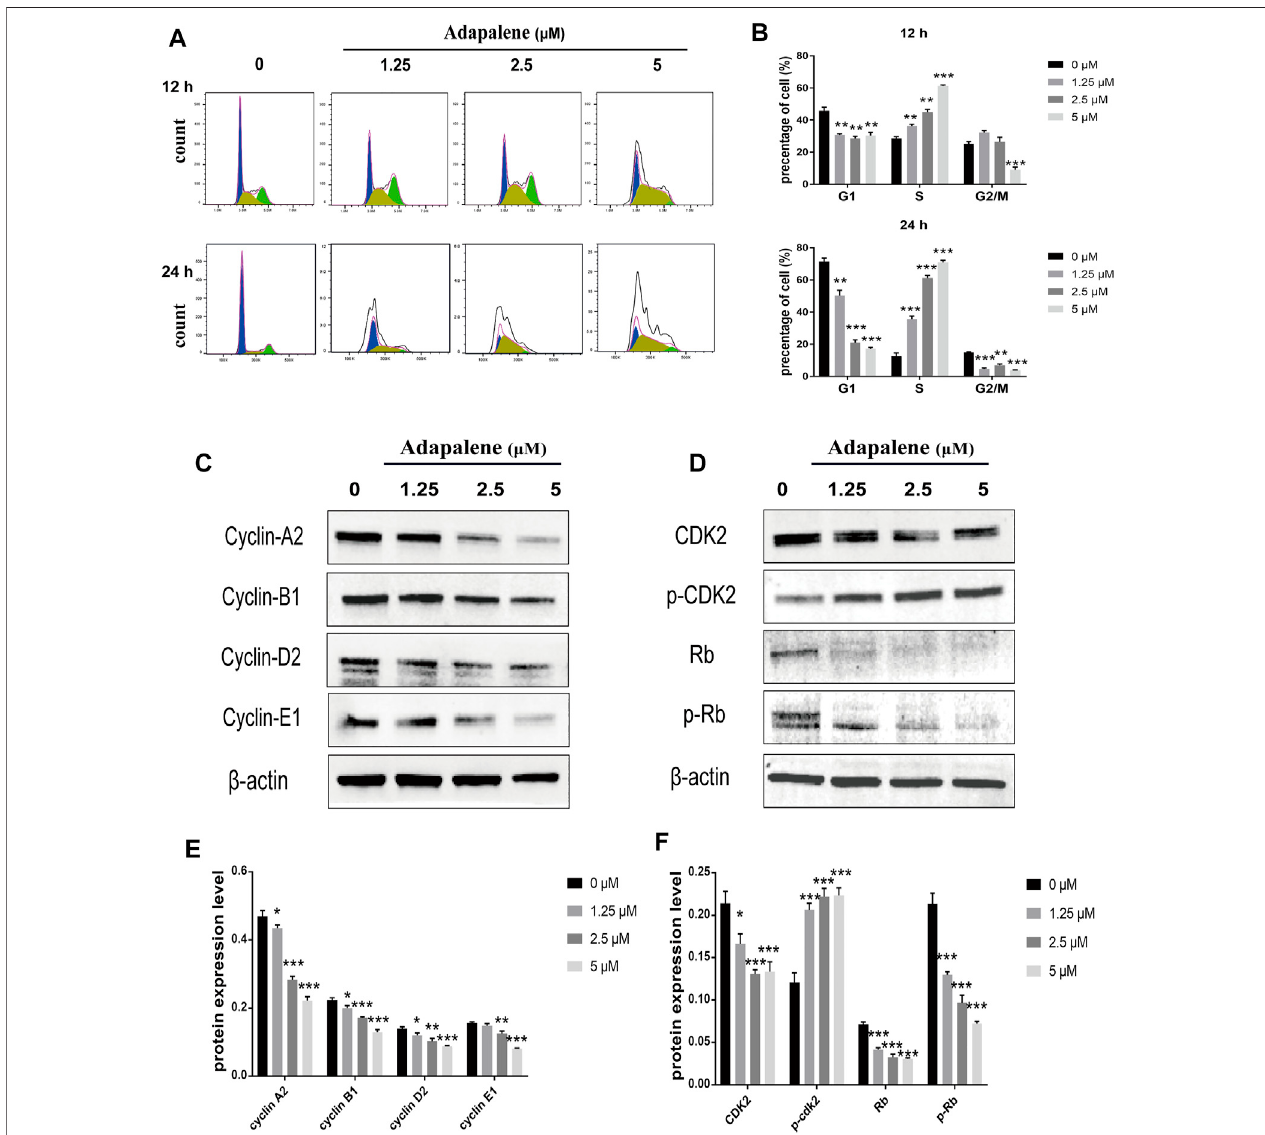
FIGURE3 | Impacts ofADA on cell cycle distribution and expression ofrelated proteins in RM-1 cells. RM-1 cells were treated using 1.25, 2.5, or 5 μ M ADA for 12 or 24 h. (A) The proportion ofcells ineach cell cycle phase wasevaluated utilizing fl owcytometry. (B) Histogramsshowed quantitativedata onthecell cycle distribution. (C,D) The protein expression of CDK2, P-CDK2, Cyclin A2, Cyclin B1, Cyclin D2, Cyclin E1, Rb, and P-Rb were detected by western blotting and (E,F) Histograms illustratedtheexpression ofeach protein, and β -actin acted astheloadingcontrol. Thesamplesderive fromthe same experiment and thatblotswereprocessed in parallel. Data are articulated as mean ± standard deviation. (* p < 0.05; ** p < 0.01; *** p < 0.001 vs. control).